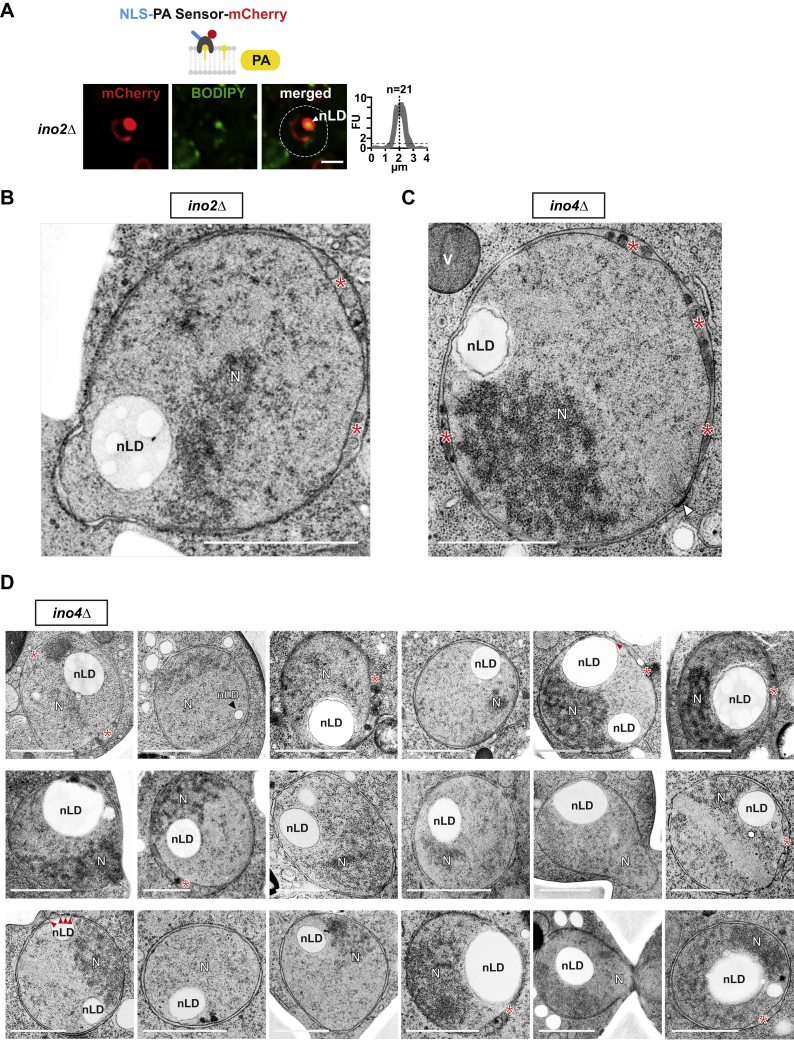
Disruption of Ino2/Ino4 Complex Results in nLD Formation, Related to Figure 4(A) Live imaging of ino2Δ cells expressing the plasmid-based NLS-bearing PA-mCherry sensor. Lipid droplets were co-stained with BODIPY. Line-scan graphs quantify the fluorescent intensity across the nucleus. nLDs were aligned in the middle of the line scan (dashed vertical line). n indicates the number of randomly selected cells, y axis: Arbitrary Fluorescence Units, FU; x axis: distance in μm. For comparison with Figure 2B the FU value 1 is marked with a horizontal dashed line. Nuclear lipid droplet, nLD. Scale bar: 2 μm.(B) TEM analysis of ino2Δ cells reveals ultrastructure of a nuclear lipid droplet (nLD) and INM evaginations (asterisks). Nucleus, N. Scale bar: 1 μm.(C and D) TEM analysis of representative examples of ino4Δ cells. Note that multiple perinuclear zones with INM evaginations/cavities can occur (red asterisks). Membrane bridges that connect nLDs to the INM are indicated with red arrowheads. Nuclear lipid droplet, nLD; nucleus, N; vacuole, V. White arrowhead - spindle pole body. Scale bar: 1 μm.